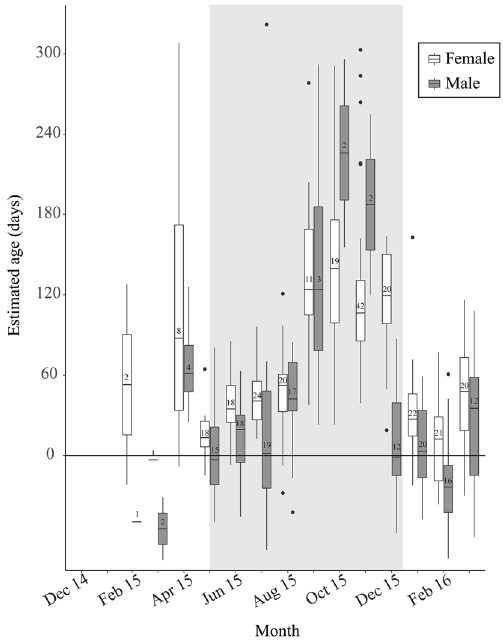
Figure 2. Estimated ages (in days) of adult female and male P. downsi flies captured at a lowland site on Santa Cruz Island, Galapagos between February 2015 and March 2016. Box plots show medians, upper and lower 75% quantiles and outliers. Numbers indicate sample size (number of flies) and the grey box indicates months that typically do not support nesting of most P. downsi